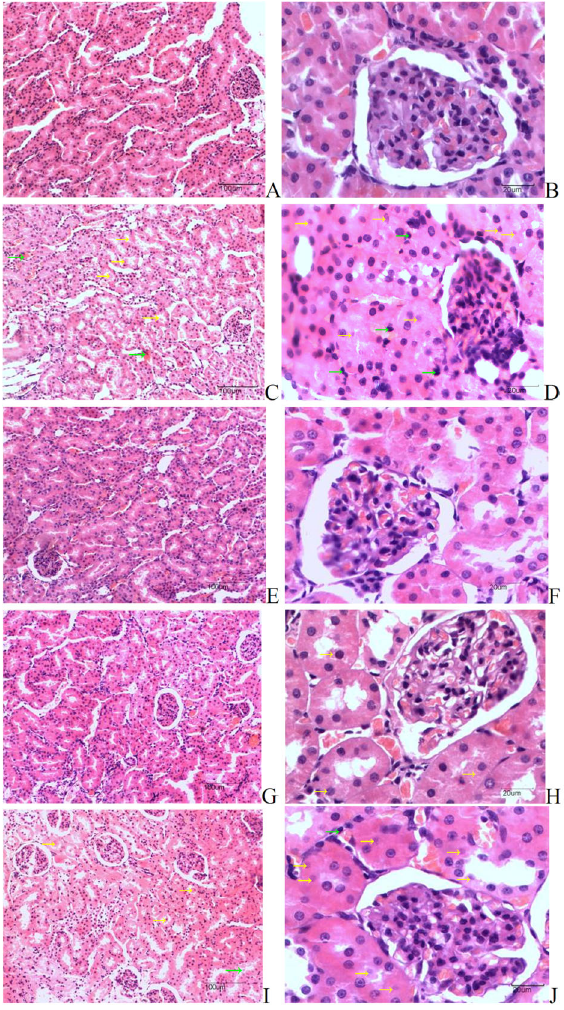
Figure 4. Changes in renal pathomorphology in rats (hematoxylin and eosin staining). A , B , sham group; C , D , shock group; E , F , shock++drainage group; G , H , shock++drainage++PPG group; I , J , shock++drainage++NaHS group. PPG: D,L-propargylglycine; NaHS: sodium hydrosulfide hydrate. Normal structure of renal glomeruliandtubules in thesham groupisshownin A and B ; protein casts (yellowarrows) and erythrocytes (green arrows) were found in renal tubule lumens of rats in the shock and shock++drainage++ NaHS groups, as shown in C and I ; tubular epithelial cells with necrosis (yellow arrows) and karyopyknosis (green arrows) were observed in the shock and shock++drainage++NaHS groups, as shown in D and J ; nearly normal architecture of glomeruli and tubules intheshock++drainage and shock++drainage++PPG groups is shown in E , F , G , and H , plus mild edema of tubular epithelial cells (yellow arrows) in H .